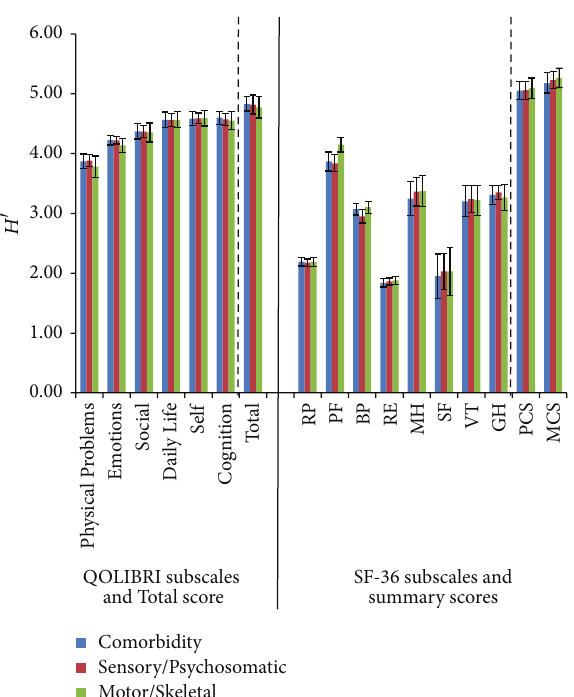
Figure 3: Shannon indices 𝐻 󸀠 (confidence intervals 95%) of all QOLIBRI and SF-36 subscales, QOLIBRI Total score and MCS and PCS for the correlates: Comorbidity, Sensory/Psychosomatic and Motor/Skeletal Complaints.